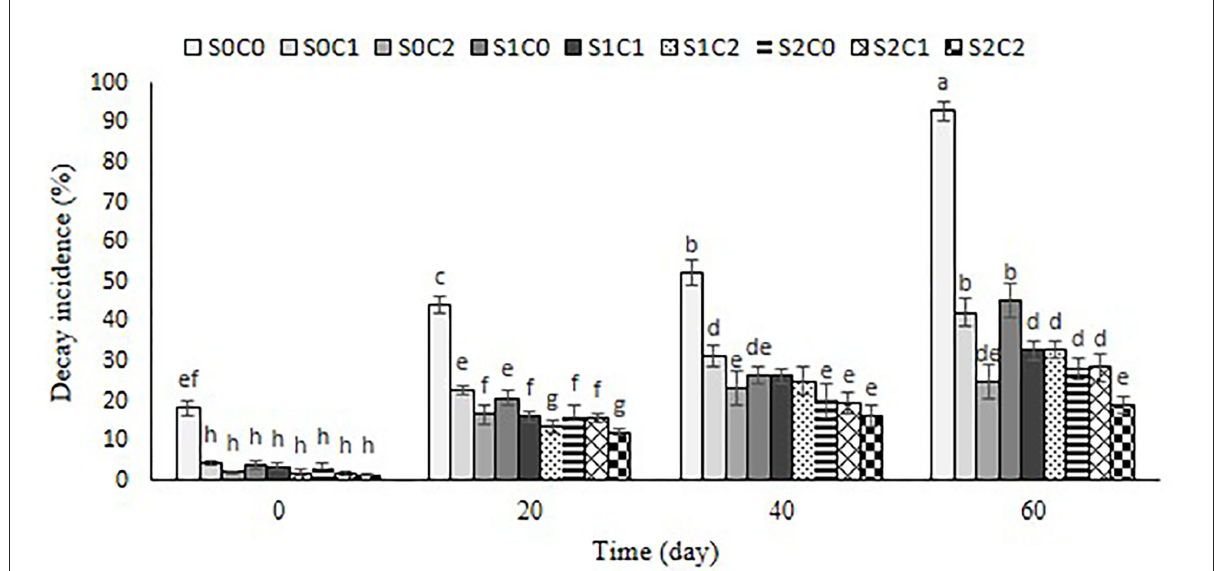
FIGURE9 Effect of foliar spraying of SA and caraway oil coating on decay incidence during 60 d of storage at 4 ± 2 ◦ C plus shelf life (2 d, 20 ◦ C). S0C0: control, S0C1: 0.3% caraway oil, S0C2: 0.6% caraway oil, S1C0: 1.5mM Salicylic acid, S1C1: 1.5mM Salicylic acid + 0.3% caraway oil, S1C2: 1.5mM Salicylic acid + 0.6% caraway oil, S2C0: 3mM Salicylic acid, S2C1: 3mM Salicylic acid + 0.3% caraway oil, S2C2: 3mM Salicylic acid + 0.6% caraway oil. Values represent mean ± SD of three replications. Different letters indicate significant differences at the 5% level according to the Duncan test.